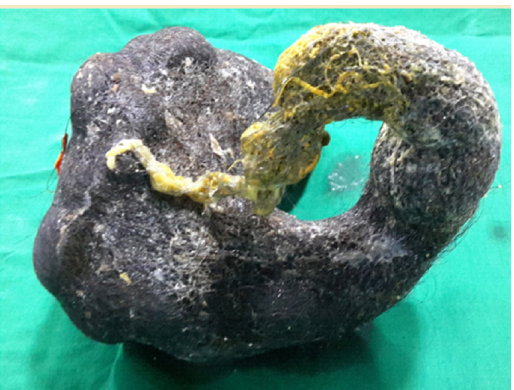
Figure 3: Specimen showing the removed trichobezoar casted in the shape of the stomach and the duodenum.